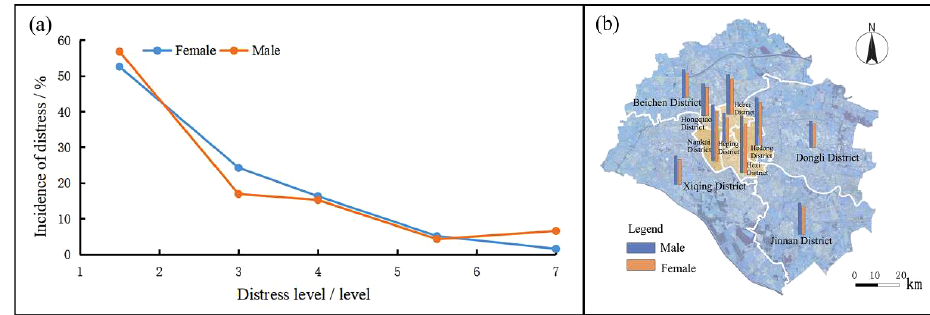
Figure 7. Gender differences and spatial characteristics of distress: a) Distribution of distress influence levels of different genders; b) Map of gender difference in emotional health risks of distress